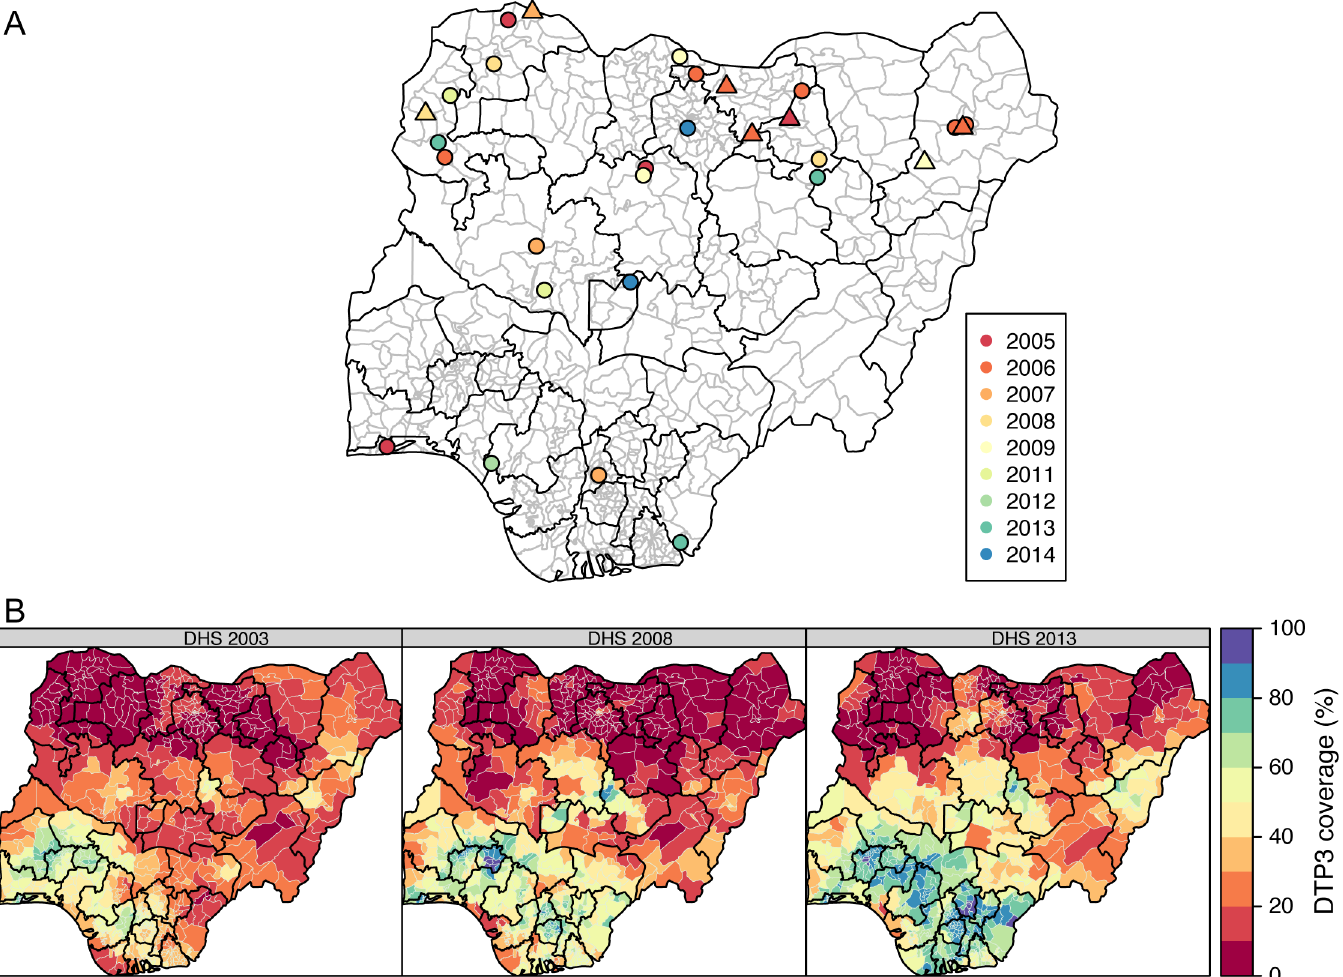
Fig 4. Independent VDPV2 emergences in Nigeria (2004 − 2014). (A) Time and geographical distribution of the first AFP case associated with each of the 29 independent VDPV2 emergences in Nigeria during 2004 − 2014. Triangles represent isolates that established circulating lineages ( > 1 case of poliomyelitis), whereas points represent single isolates. The triangles and points representing the emergence events are randomly plotted within the corresponding districts. The colours correspond to the year of onset of paralysis. (B) Maps of the predicted DTP3 coverage by district for the 2003, 2008 and 2013 DHS. The publication of this map does not imply the expression of any opinion whatsoever on the part of WHO concerning the legal status of any territory, city or area or of its authorities, or concerning the delimitation of its frontiers or boundaries.